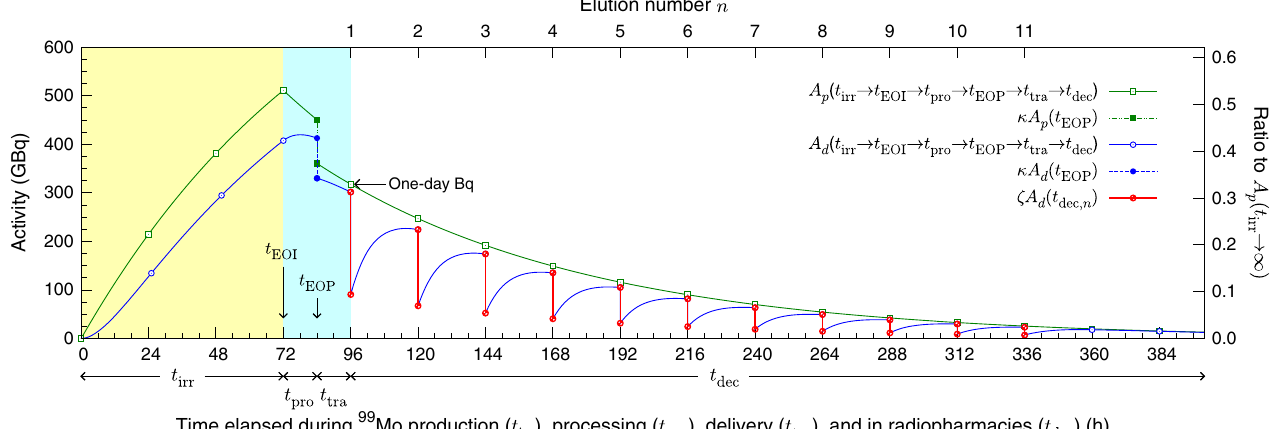
FIG. 13. Comprehensive view of the modeled activities of photonuclear-produced 99 Mo = 99 m